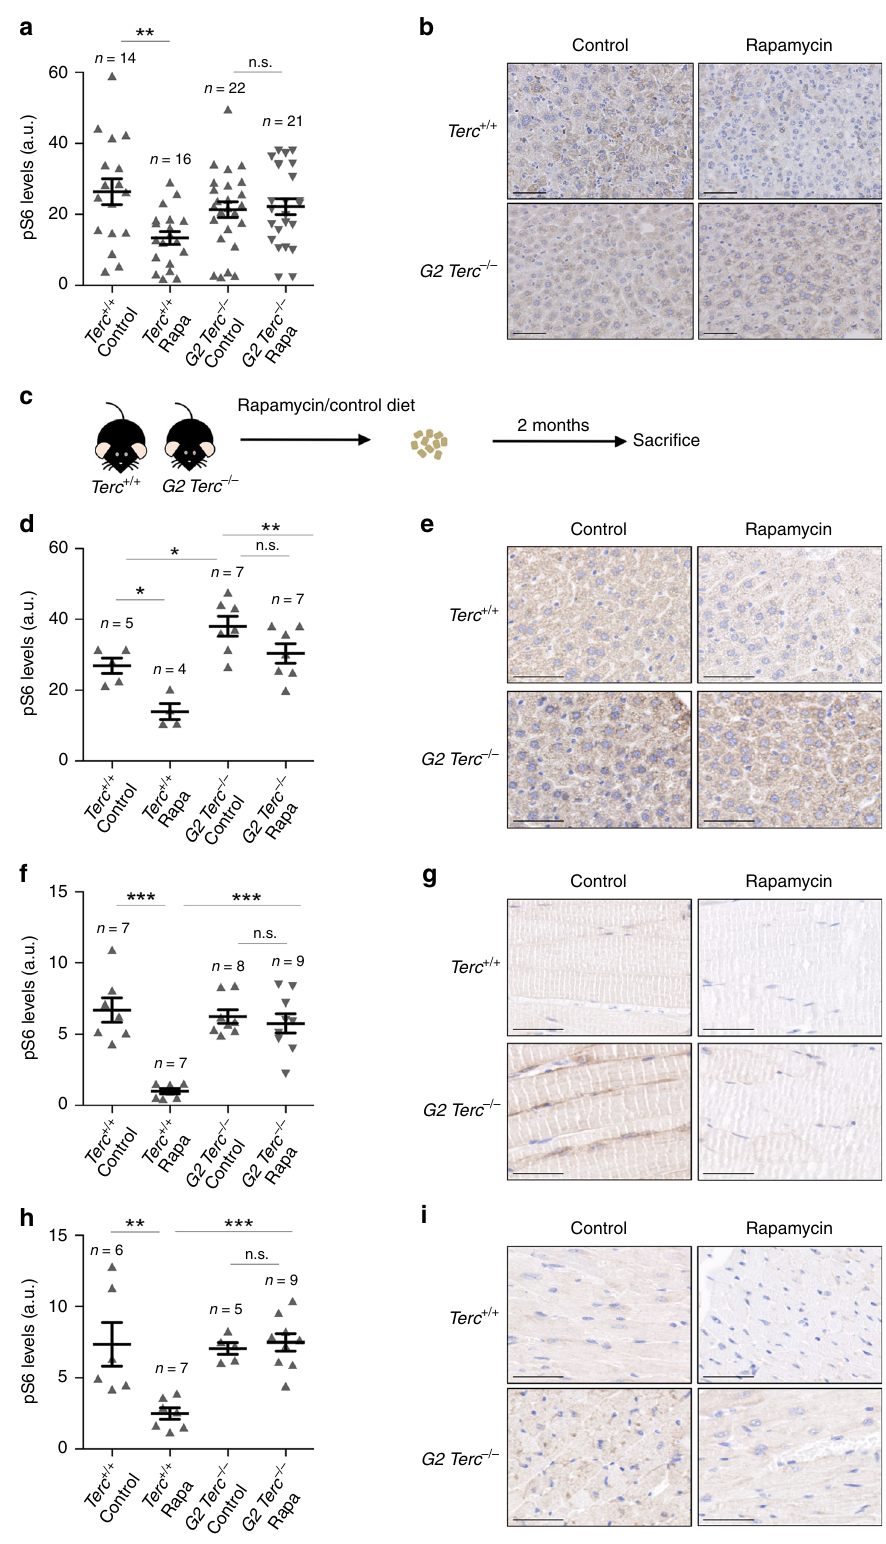
Fig. 3 Terc − / − mice under a chronic rapamycin treatment retain S6 phosphorylation in the liver. a , b Quanti fi cation ( a ) and representative images ( b ) of phosphorylated ribosomal protein S6 (pS6) expression in liver from rapamycin or control fed Terc + / + and G2 Terc − / − mice at the endpoint. c Two to 6 months old Terc + / + and G2 Terc − / − mice were fed rapamycin or control diet and sacri fi ced 2 months later. d – i IHC quanti fi cation ( d , f , h ) and representative images ( e , g , i ) of pS6 expression from sections of liver ( d , e ), skeletal muscle ( f , g ), and heart ( h , i ) of mice control and rapamycin treated for 2 months. a.u. arbitrary units. Scale bars, 100 μ m. Error bars represent the SE. n = number of mice. Statistical signi fi cance was determined by one-way Anova with post hoc Tukey test. * p ≤ 0.05; ** p ≤ 0.01; *** p ≤ 0.001; n.s. not signi fi cant. Source data are provided as a Source Data fi